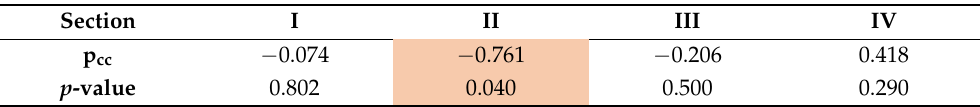
Table 4. Circular correlations (p cc ) between the hue angles (h ◦ ) of the main and background colors in Sections I, II, III, and